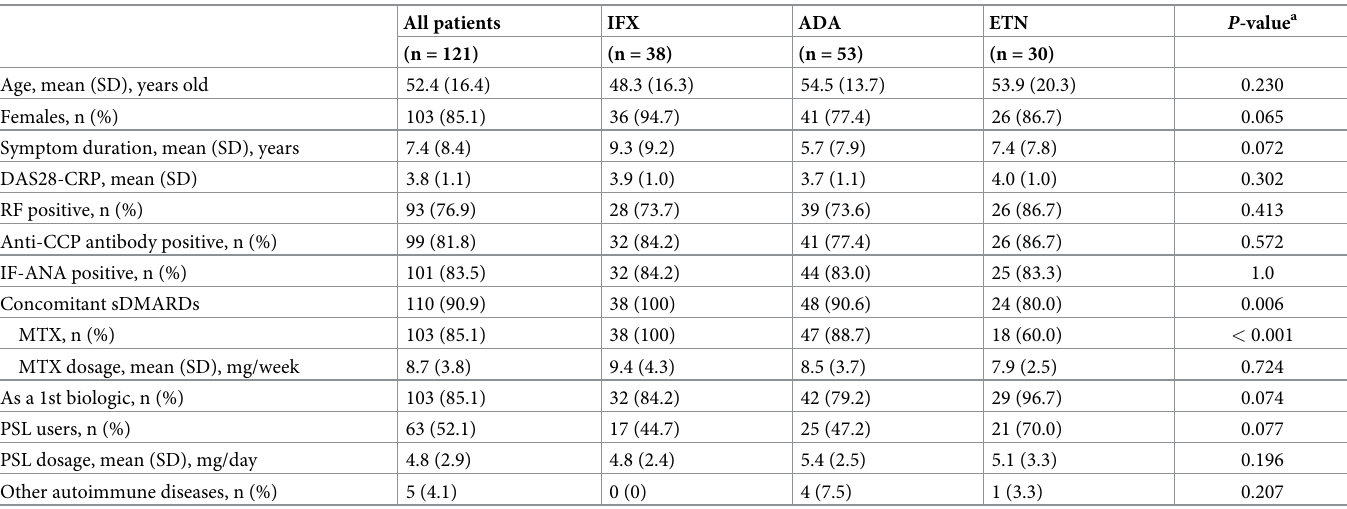
Table 1. Characteristics of 121 RA